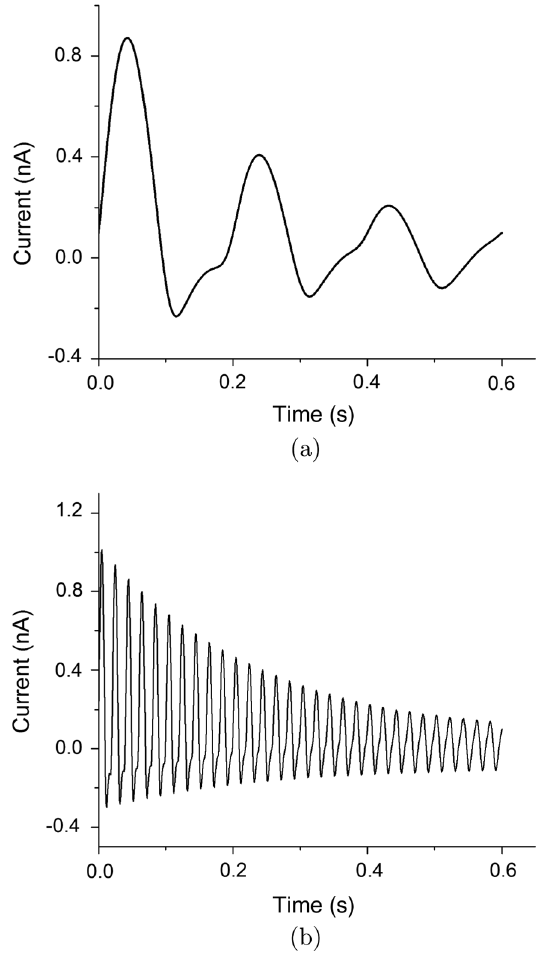
FIG. 10. Calculated current trace for 100 channels, obtained using the open-probability curve of Fig. 2, Ohm’s law, and the exponential decay corresponding to the inactivation process, i.e., I ð t Þ ¼ N(cid:4)V ð t Þ p ½ V ð t Þ(cid:5) exp ð(cid:2) t=(cid:5) Þ , where N ¼ 100 is the number of channels, (cid:4) is the conductivity of a single channel sin ð 2 (cid:6)(cid:3)t Þ is the sinusoidal applied voltage, (170 pS), V ð t Þ ¼ V 0 and p ð V Þ is the open probability at voltage V . (a) (cid:3) ¼ 5 Hz ; (b) (cid:3) ¼ 50 Hz